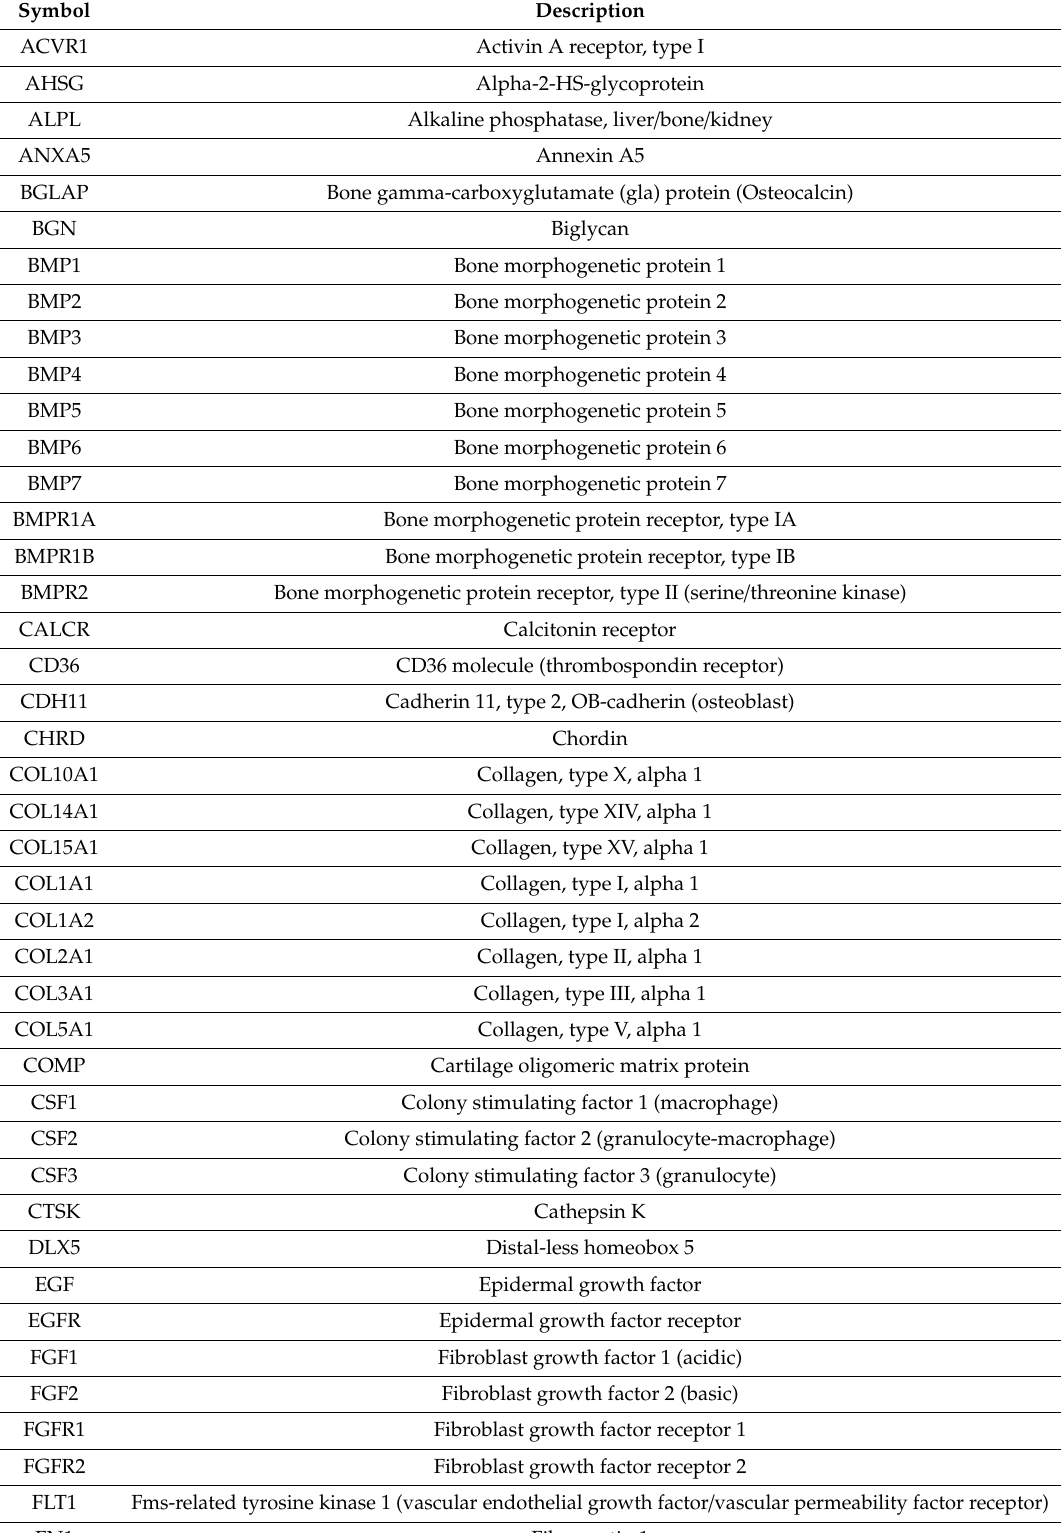
Table 1. List of genes examined by the osteogenic RT 2 Profiler PCR